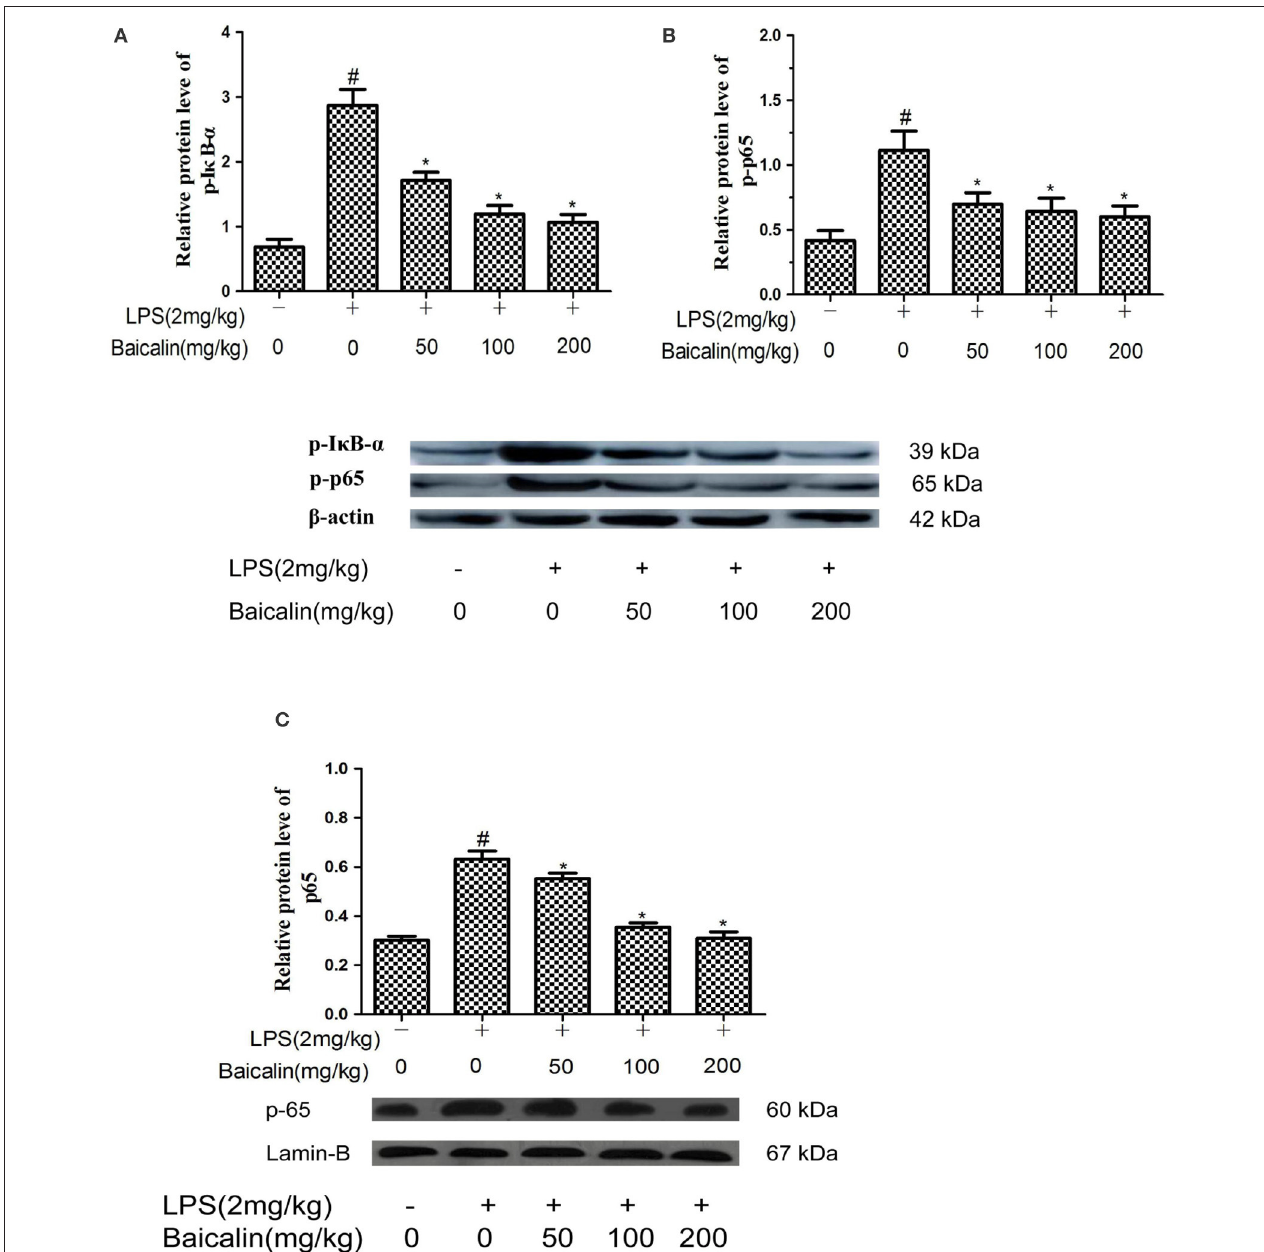
FIGURE 6 | Baicalin inhibited NF- κ B pathway activation. The expression of p-IkB α (A) , p-p65 (B) , and nuclear p65 (C) . Data are expressed as the mean ± SD . ( n = 6). * P < 0.05vs. LPS group; # P < 0.05vs. control